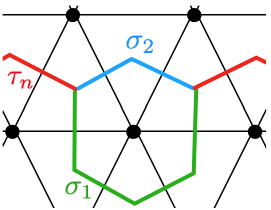
FIG. 16. Splitting of an S n domain wall. In the large- q limit with randomly located measurements, and with n − 2 < α < n − 1, we evaluate the dominant splitting process at downward- facing triangle, with τ n = ( 1 2 . . . n ) . We find that this process is one where the number of transpositions in the decomposition of the permutations σ 1 and σ 2 is given by | σ 1 | = 1, | σ 2 | = n − 1. Other splitting processes are parametrically smaller in q − 1